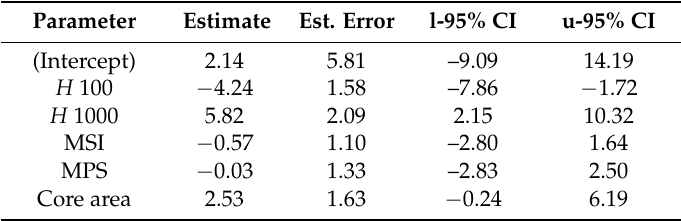
Table 3. The model for predicting the effect of landscape heterogeneity on SBS spread in a